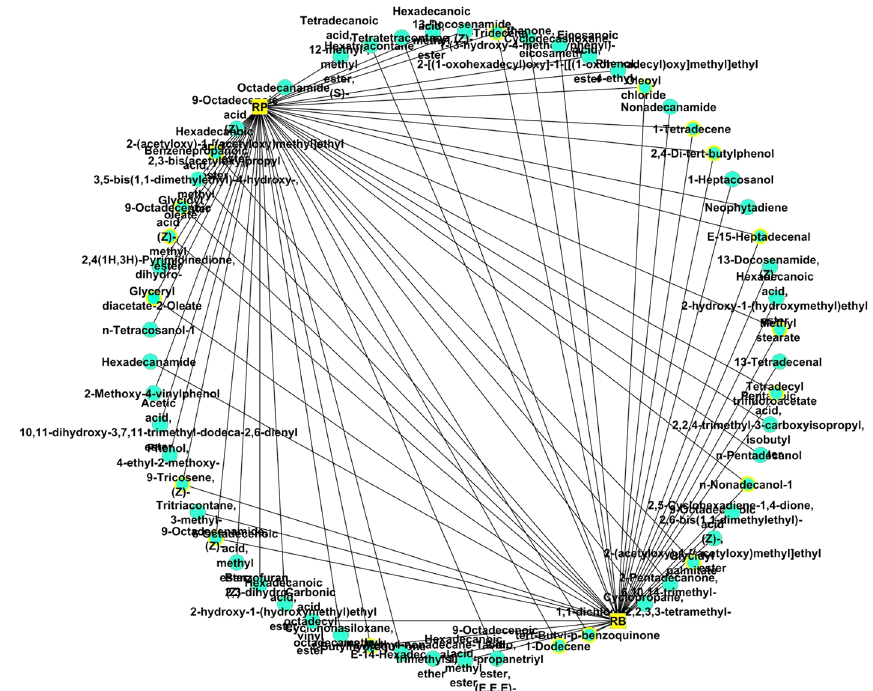
Fig. 4 Herb-compositive compound network. Edges: interactions between herb and compositive compounds; yellow square nodes: Ruellia prostrata (RP) and Ruellia bignoniiflora (RB) herbs; green round nodes: RP–RB compositive compounds; green nodes with yellow border are compounds shared by the two Ruellia